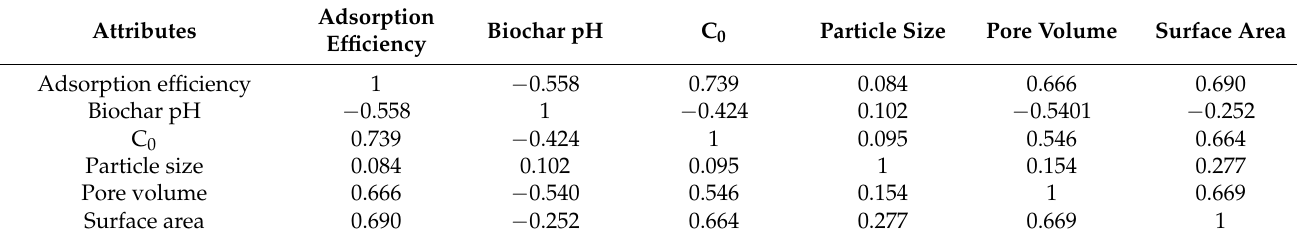
Table 5. Pearson correlation matrix between any two features of agro waste, and between any variable and the target variable (adsorption efficiency).